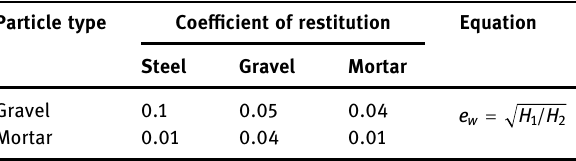
Table 3: Coe ffi cient of restitution of the particles Particle type